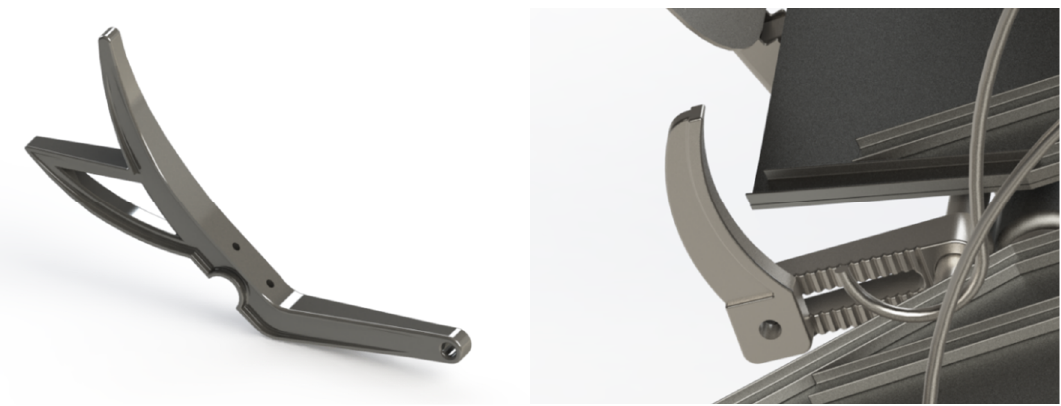
Figure 22. Compacting needle ( left ) and trigger of the knotting system ( right ).